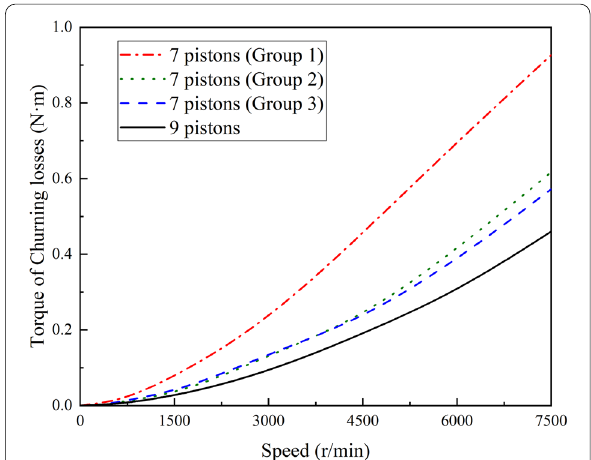
Figure 15 Comparison of the torque results of churning losses of the pump with the same